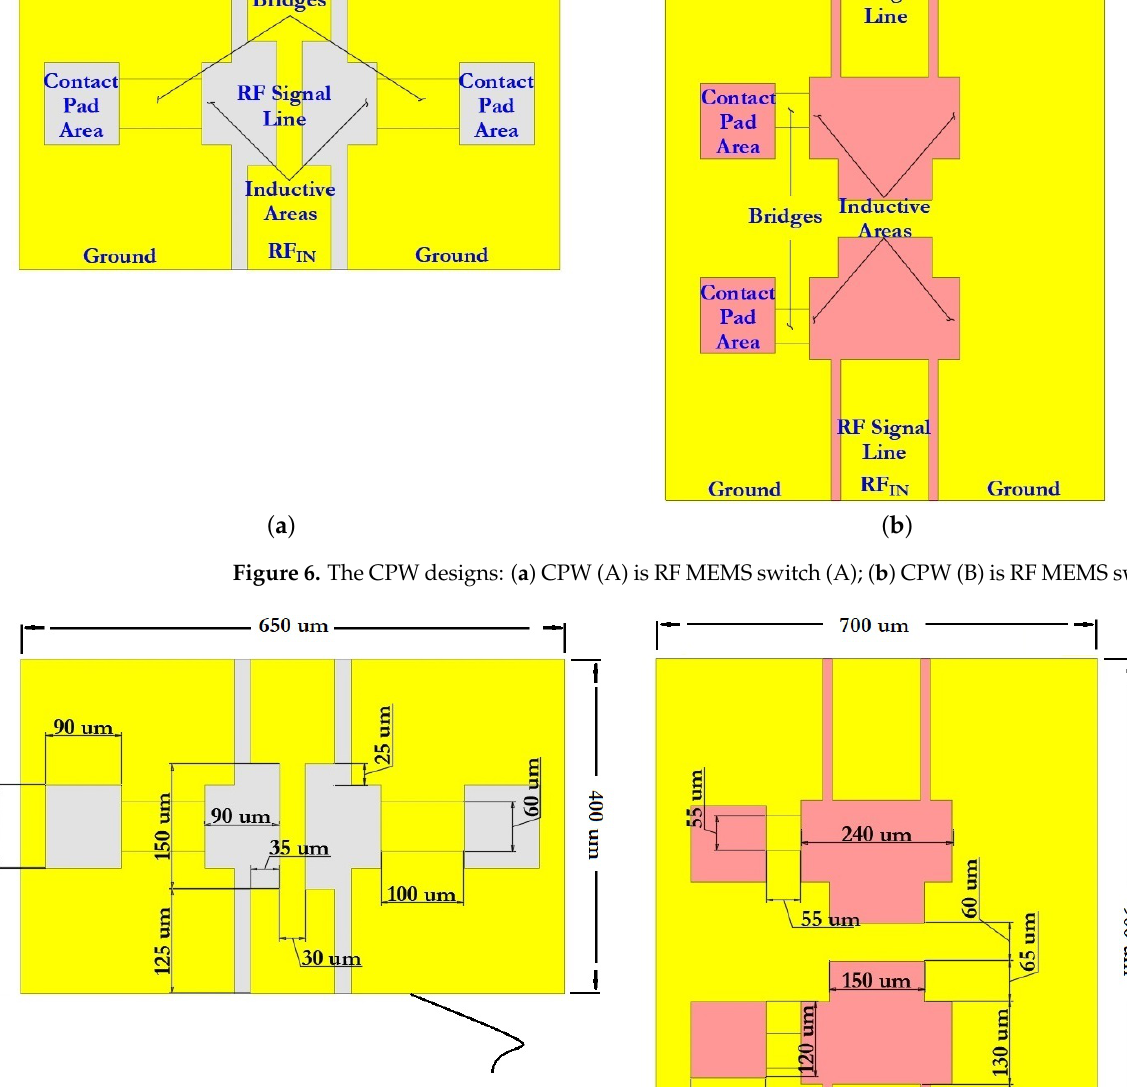
The dimensions for CPW (A) and CPW (B) are specified in Table